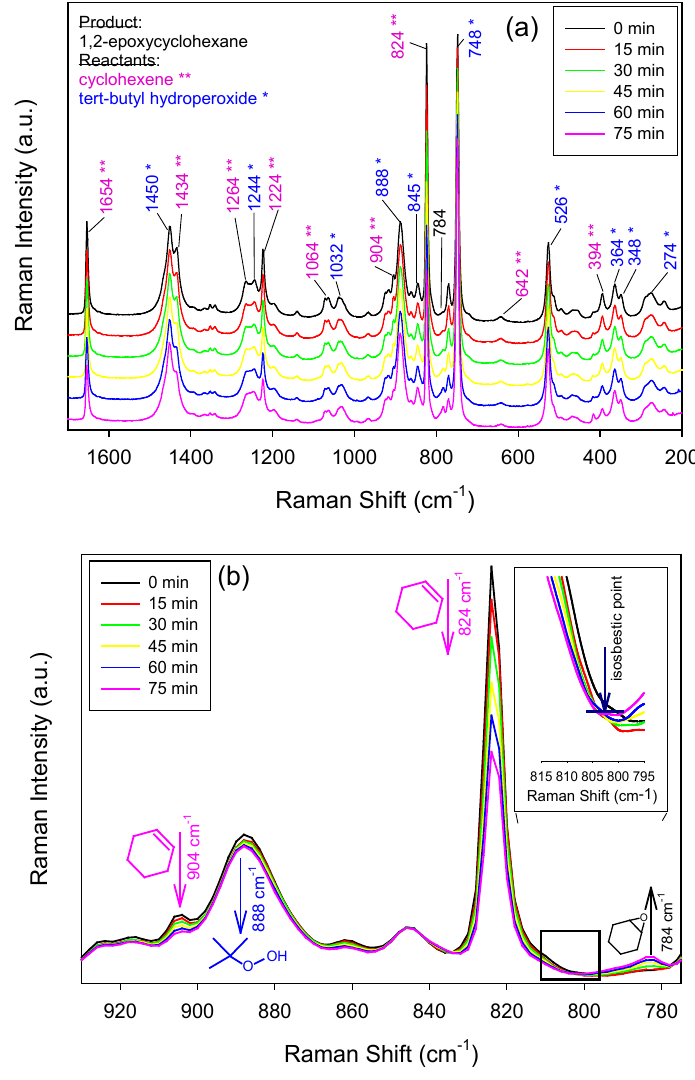
Figure 6. Representative Raman spectra during the photocatalytic cyclohexene epoxidation with t -BuOOH over V 0.25 Ti 2 /MCM-41 catalyst at 60 °C for 75 min: ( a ) full spectra; ( b ) partial spectra in range of 775–930 (cm − 1